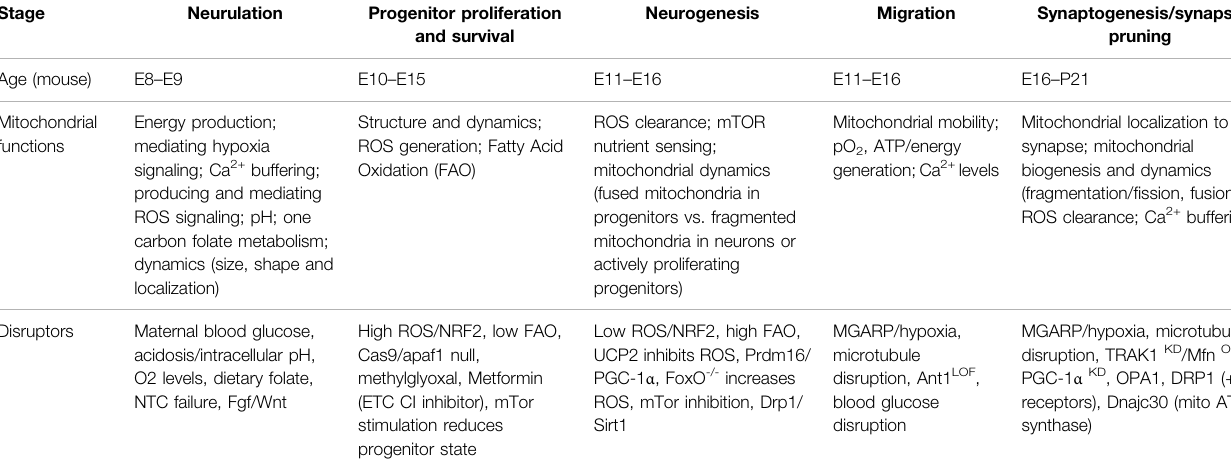
TABLE 1 | Summary of known mitochondrial roles in early forebrain development.